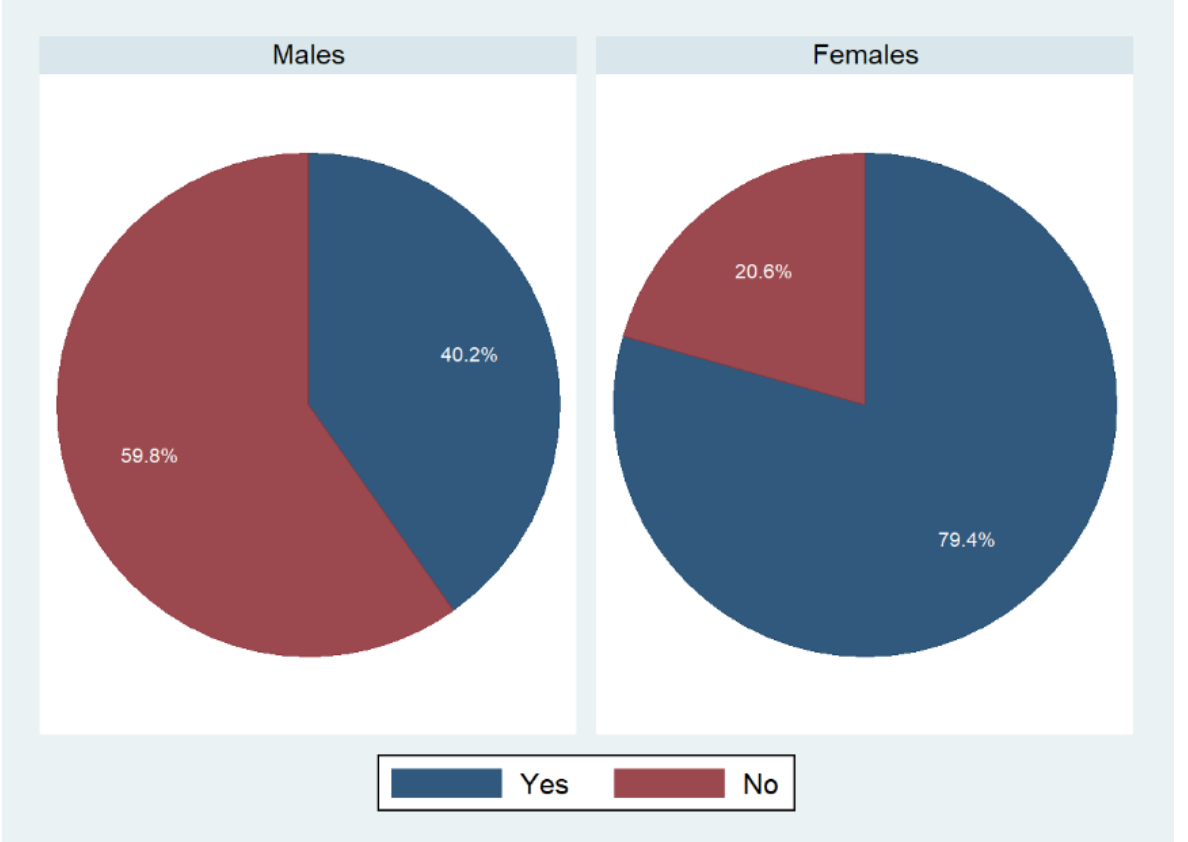
Figure 1. Meal planning and preparation in family stratified by gender: an overview. Weighted percentages, n = 9087. p < 0.001 based on a Rao – Scott test exploring potential associations between main person cooking and sex. Table 2. Participants’ replies to the question “Are you the person who does most of the planning or preparing of meals in family?” stratified by age